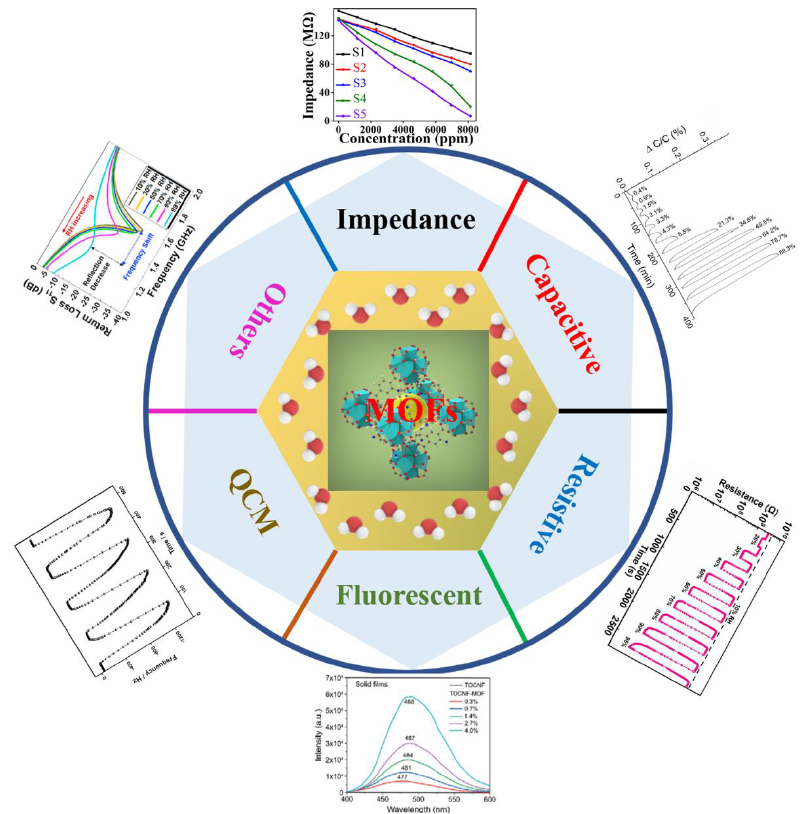
Figure 1. Different types of MOF − based humidity sensors. Reproduced with permission from Ref. [53]. Copyright 2022, IEEE. Reproduced with permission from Ref. [54]. Copyright 2020, American Chemical Society. Reproduced with permission from Ref. [55]. Copyright 2022, Elsevier. Reproduced with permission from Ref. [56]. Copyright 2022, Wiley − VCH GmbH. Reproduced with permission from Ref. [57]. Copyright 2017, American Chemical Society. Reproduced with permission from Ref. [58]. Copyright 2021, Elsevier.